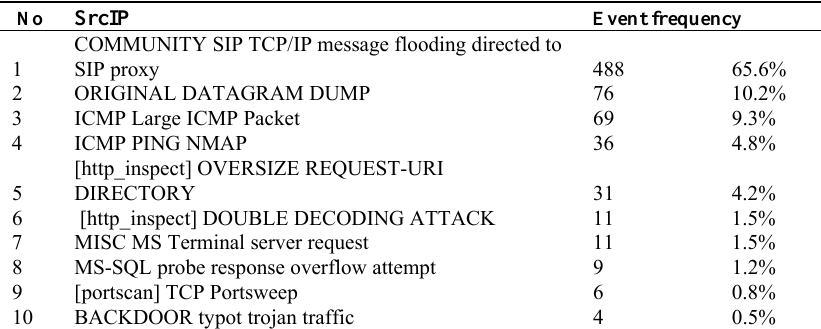
Table.3. Top 10 Summary of events